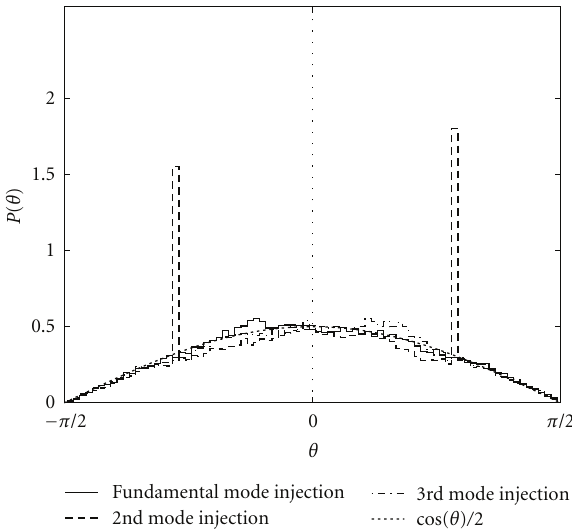
Figure 1: An example of a random-shaped quantum dot with two waveguides and the definition of the coordinate system.